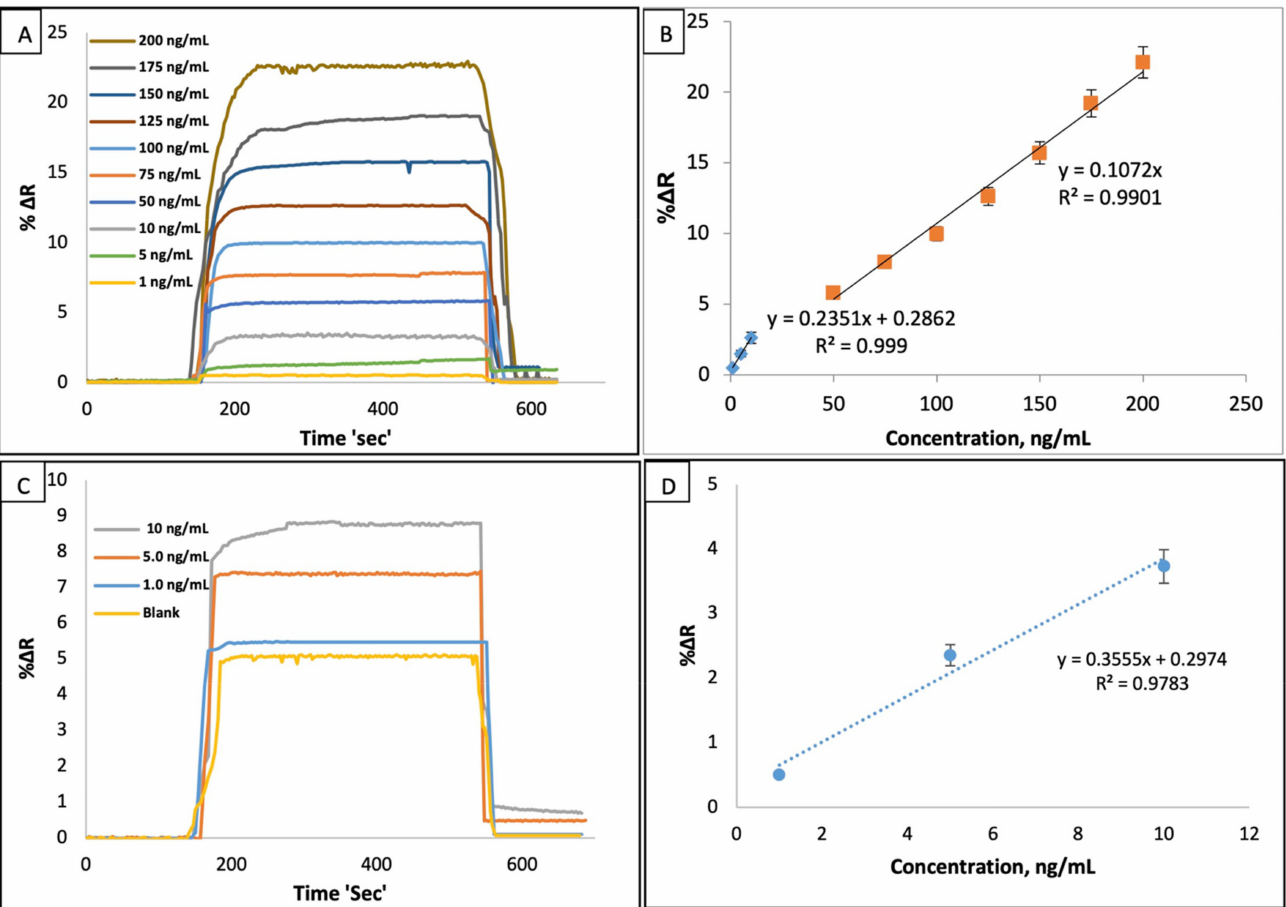
Figure 3. The responses and the linearity of the I-SPR sensor for IgM concentrations ( A ), ( B ) in the aqueous solution; (flow rate: 150 µ L/min and T: 25 ◦ C), and the responses and the linearity of the I-SPR sensor ( C ), ( D ) in the artificial plasma (flow rate: 150 µ L/min, pH: 7.4 and T: 25 ◦